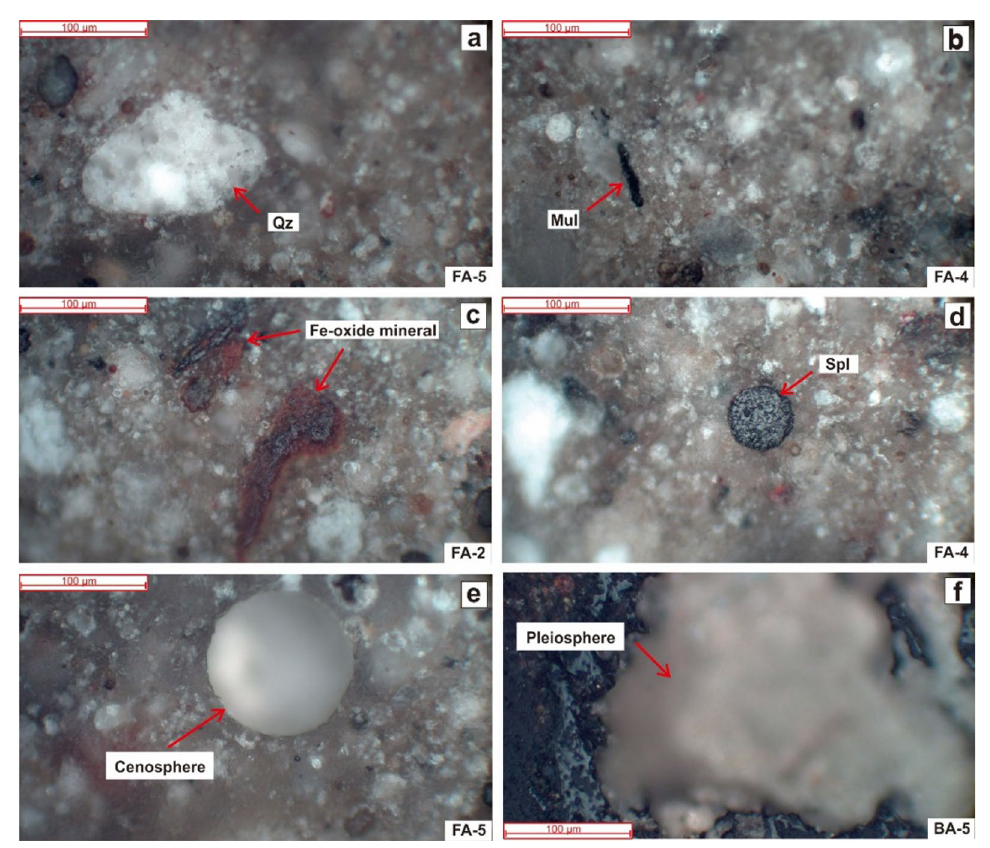
Fig. 7 Inorganic components of fly ash (FA) and bottom ash (BA). a Quartz (Qz); b Mullite (Mul); c Fe-oxide minerals; d Spinel (Spl); e Glass cenospheres; and glass f Pleiospheres. (All photomicrographs are taken under white light)